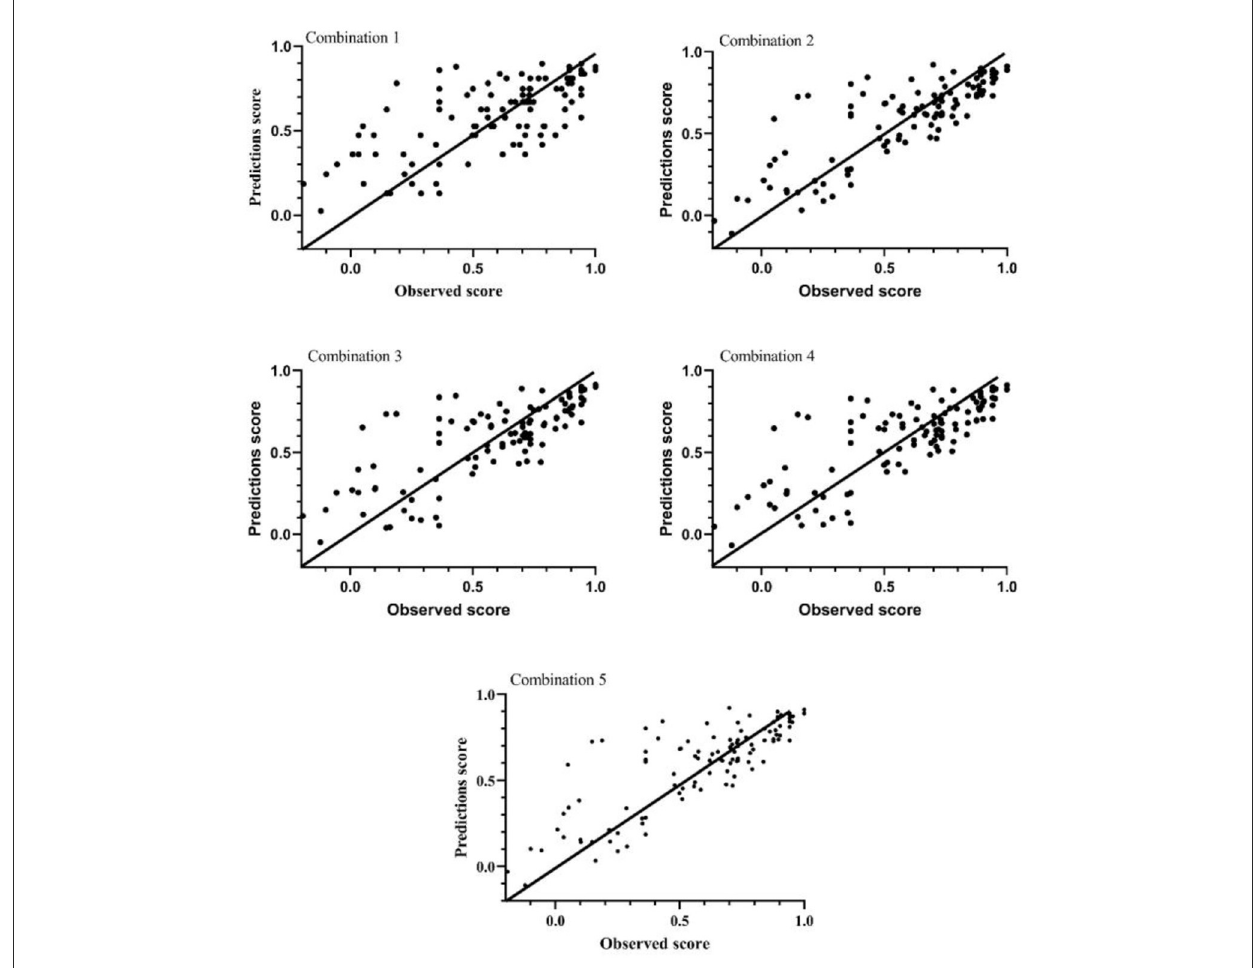
FIGURE2 The observed and predicted EQ-5D-5L utility score.